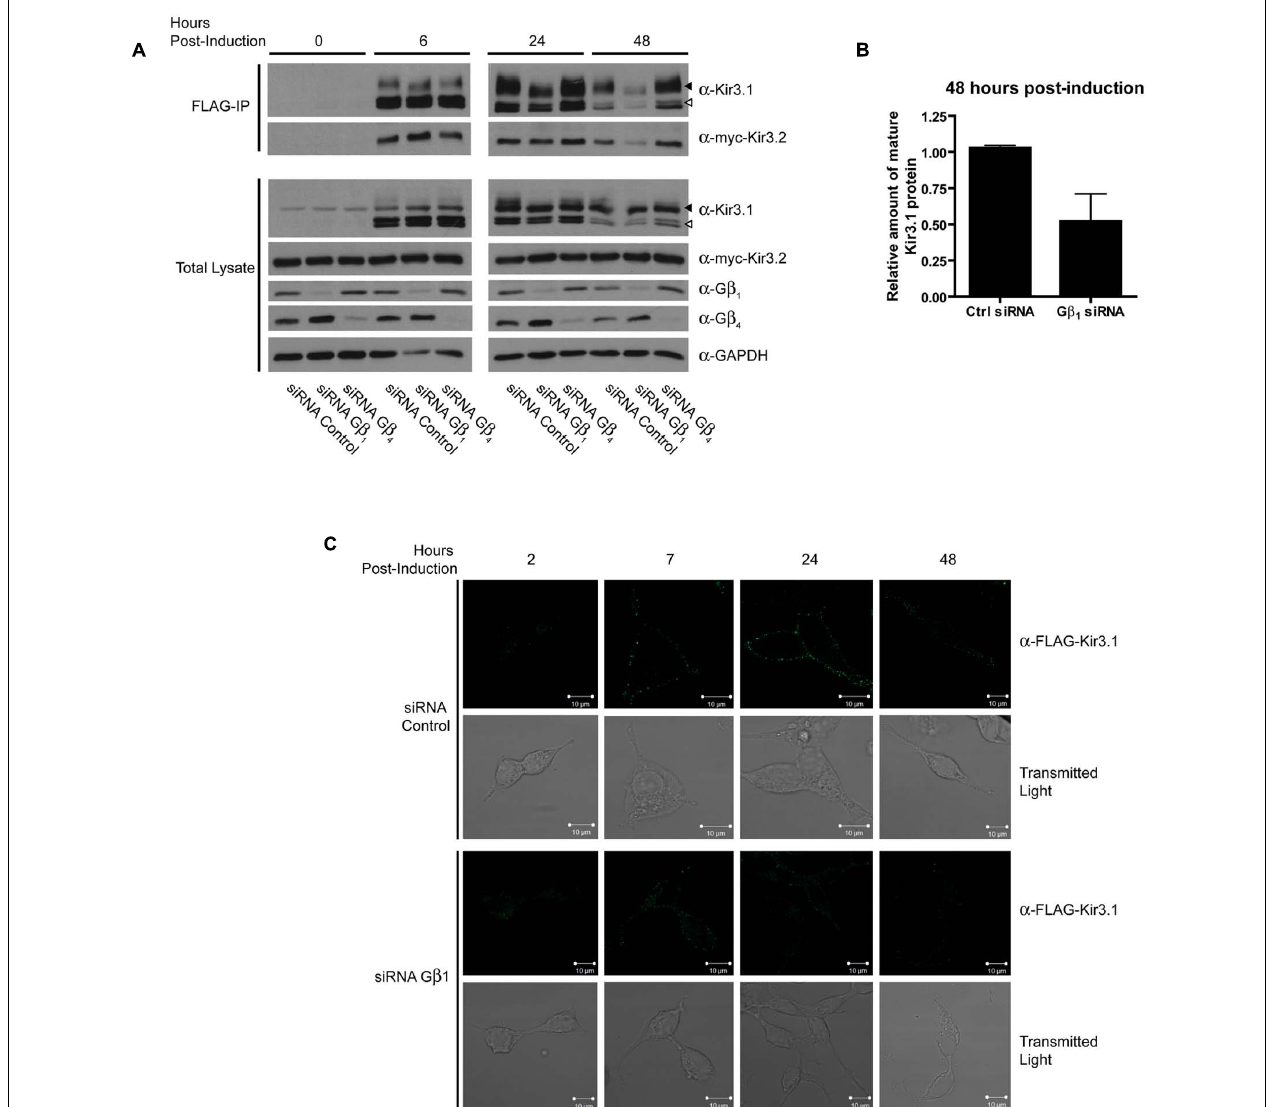
FIGURE 1 | G β 1 but not G β 4 knockdown reduces stability of Kir3.1. (A) Flp-In-Trex-FLAG-Kir3.1 cells transfected with myc-Kir3.2 and G β 1 , G β 4, or control siRNA were induced to express FLAG-Kir3.1 with 1 μ g/mL of tetracycline for 30 min and then chased for 0, 6, 24, or 48 h. Upper panel: cells were lysed and FLAG-Kir3.1 was immunoprecipitated using an α -FLAG antibody. Samples were then analyzed by western blot to detect levels of FLAG-Kir3.1 and myc-Kir3.2. Lower panel: total cell lysates showing expression of Kir3.1, Kir3.2, G β 1 , G β 4, and GAPDH (loading control). Results are representative of three independent experiments. White arrow indicates immature channel proteins while black arrow indicates correctly processed Kir3.1. (B) Densitometric analysis of data